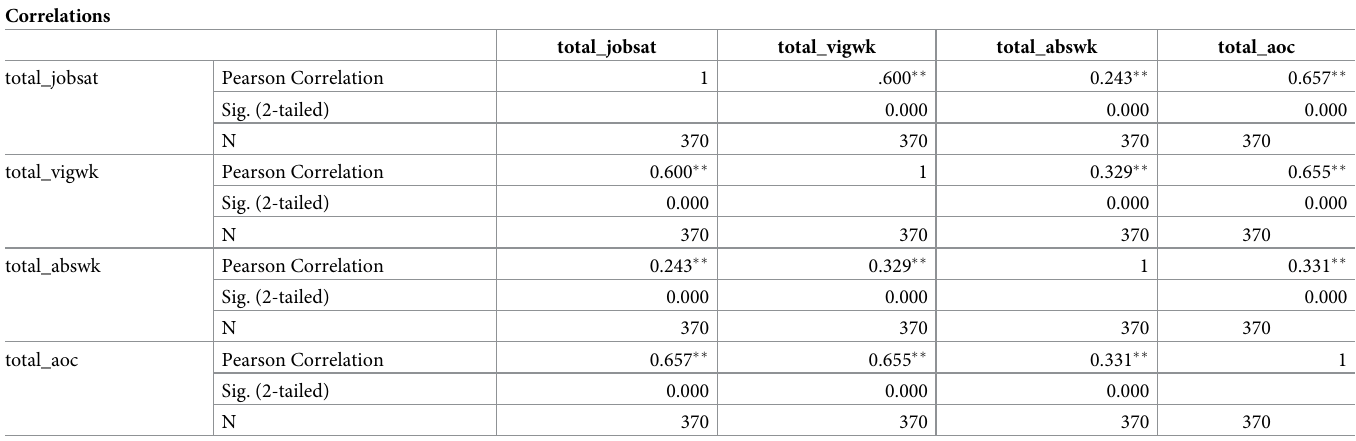
Table 4. Correlation analysis.